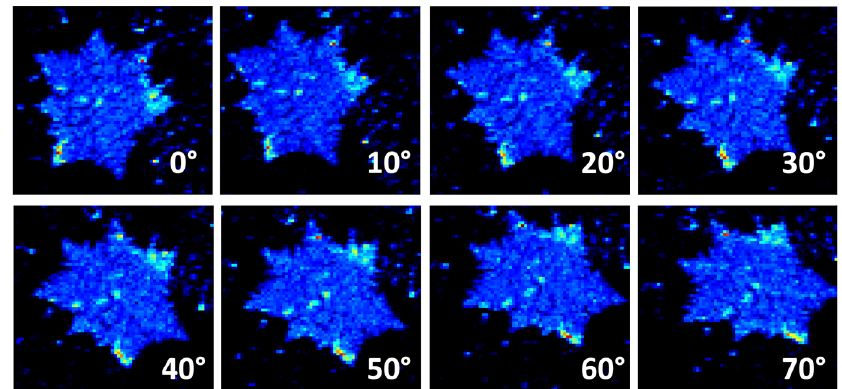
FIG. 6. Azimuthal dependence of THG scans of the graphene star ‘‘B’’ shown in Fig. 4(a), indicating the isotropy of the in-plane nonlinear optical response of